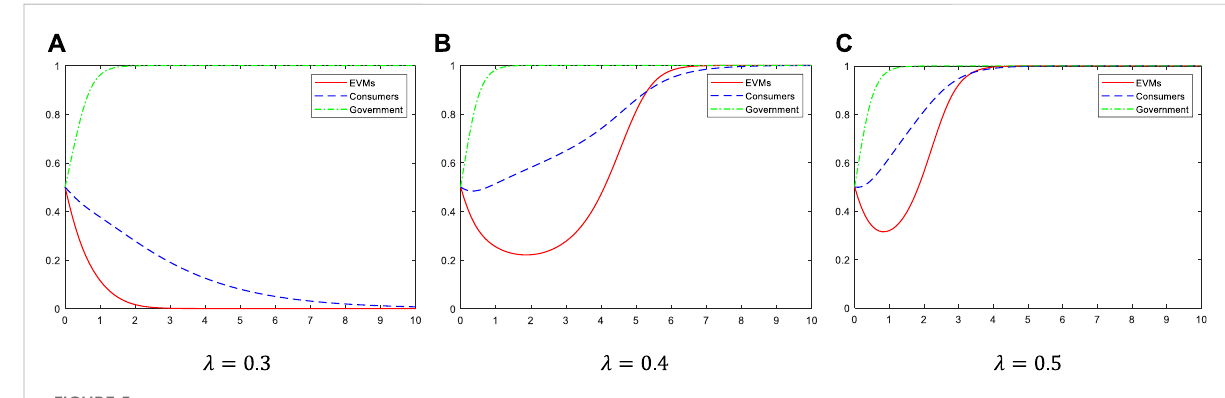
FIGURE 5 Impact of different values of supervision on the evolutionary